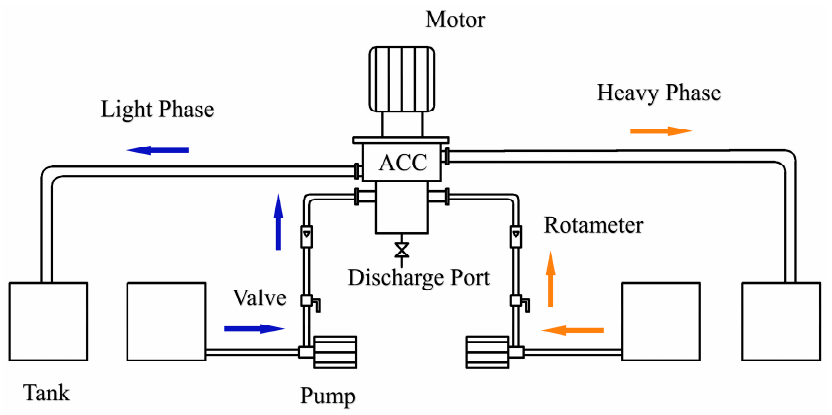
Figure 2. Flow chart of the experiment process.